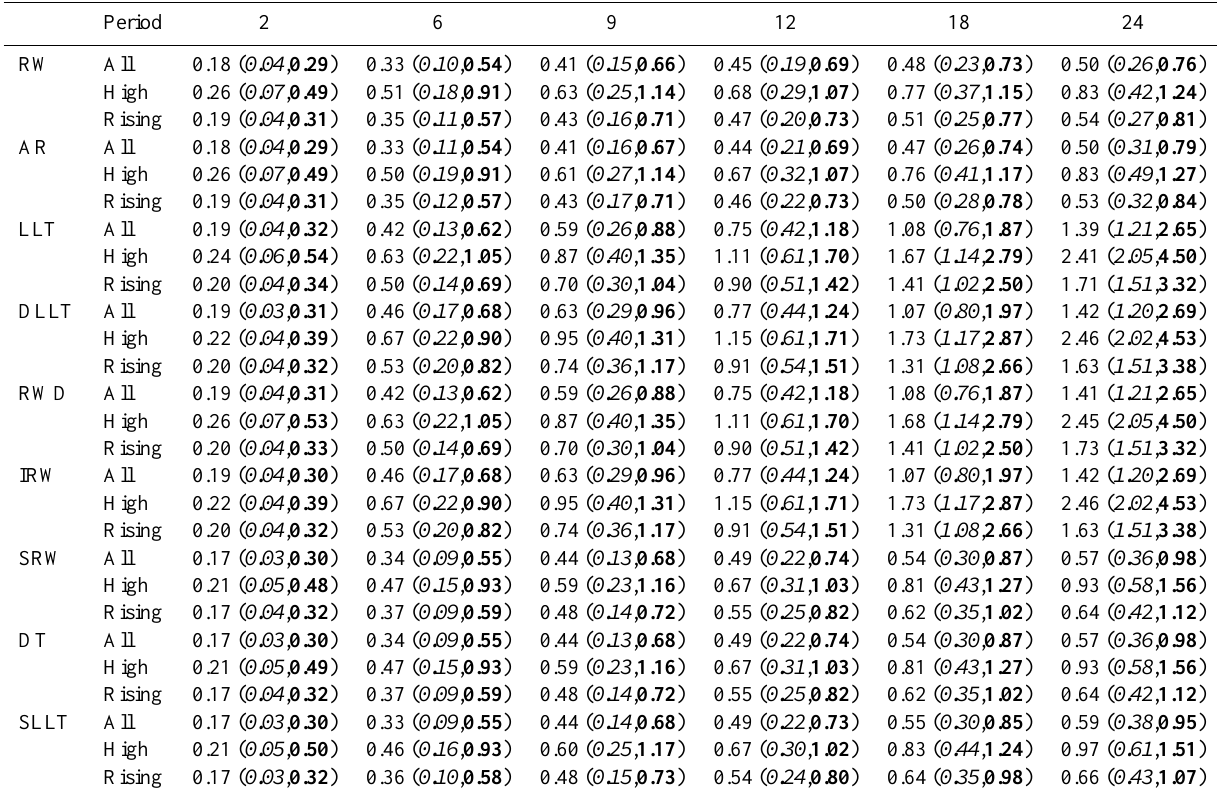
Table 4. Precision of the forecasts (see text for definition) during calibration at Welsh bridge. Bracketed results are those for the SEFE calibration with the italicised and bold values corresponding to the empirical and theoretical symmetric bounds. Results are shown for all the time periods, high levels ( > 2m) and periods where the hydrograph is rising for different combinations of lead time (hours) and GRW